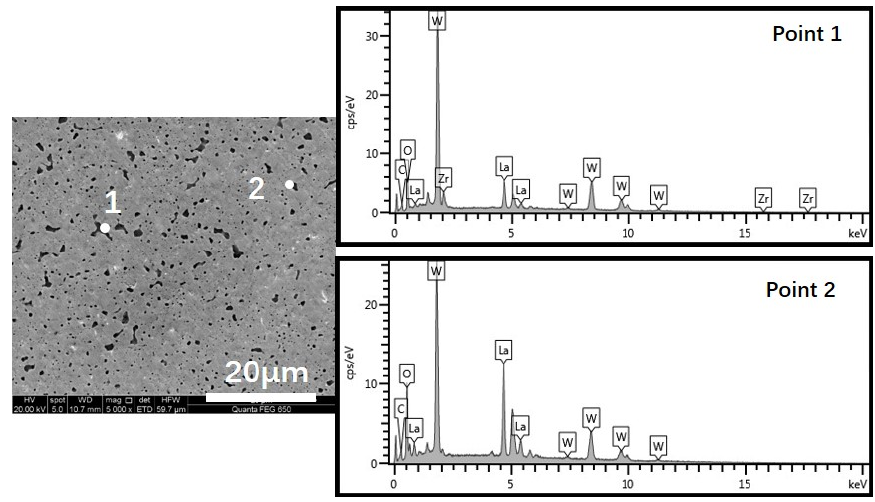
Figure 6. SEM and EDS images of the sample doped with 0.1%ZrH 2.